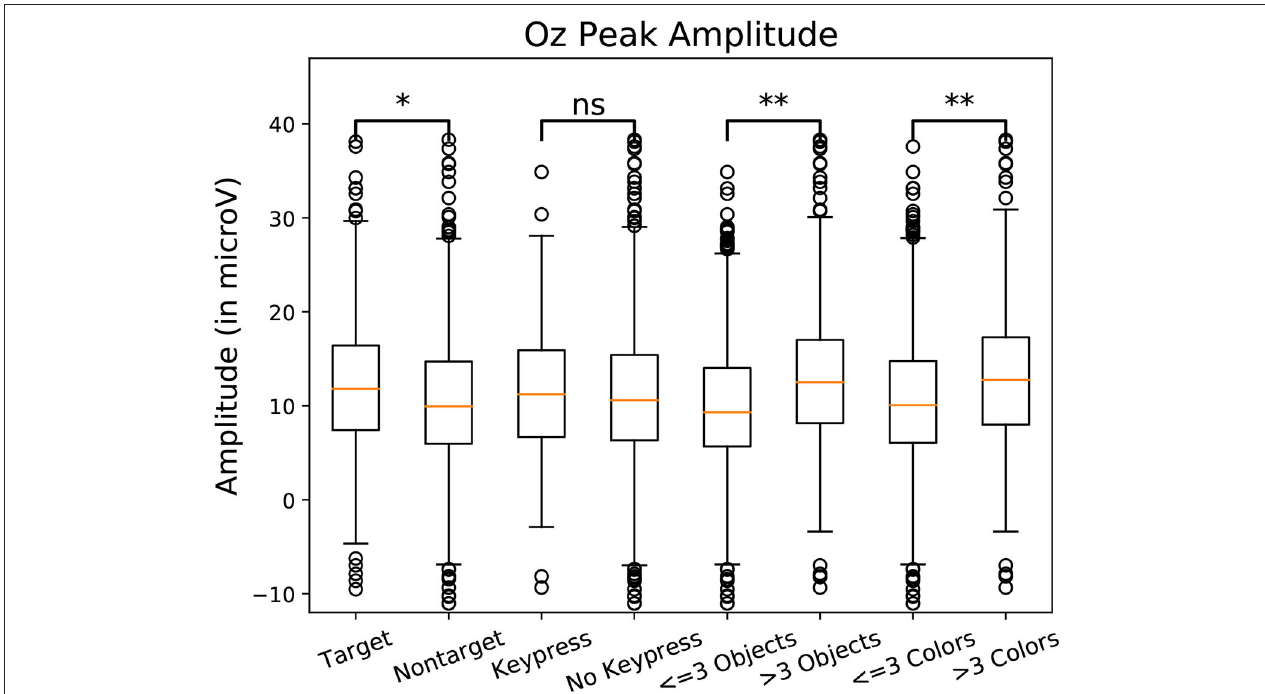
FIGURE 8 | Amplitude of the P100 component peak measured at the Oz electrode measure for one subject. Amplitudes were grouped by class. Eight categories were compared in pairs. Target/non-target define if a target object was fixated. Keypress/No Keypress is determined based on the participant performing a keyboard press (the space key) during fixation. The categories labeled Objects are defined depending on the amount of shapes in the foveal region. The categories labeled “Colors” are defined depending on the amount of different colors in the foveal region. Significant differences are present between 3 pairs of categories. Using Student t -test: “ns” means p -value > 0.05, “*” means p -value < 0.05, “**” means p -value < 0.01.